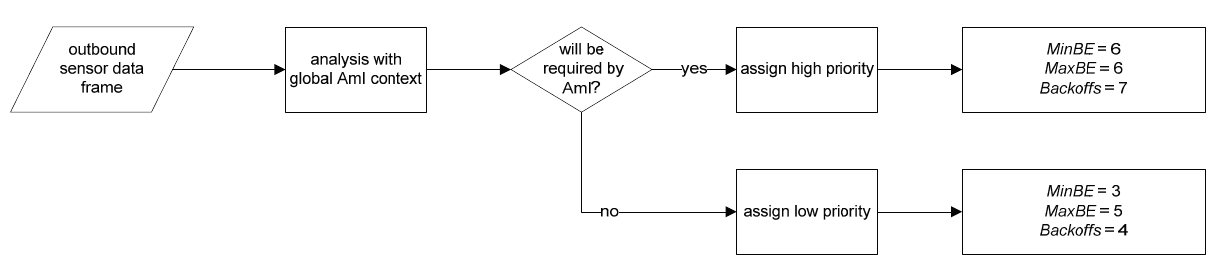
Figure 7. Context-aware